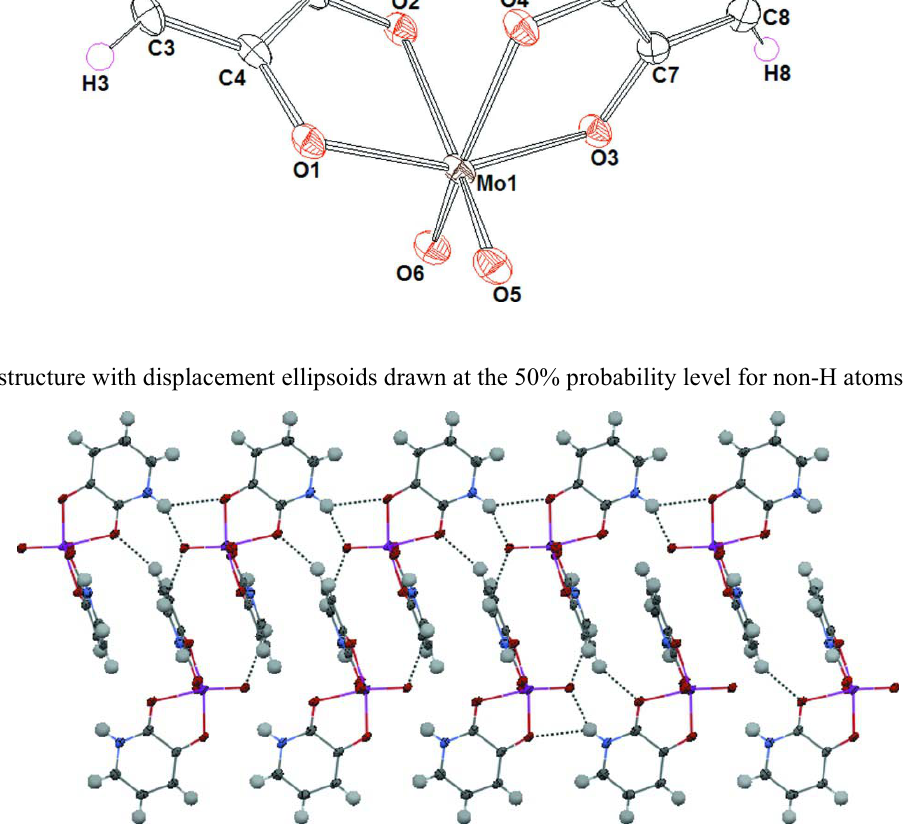
Figure 2 Parallel chains made through intermolecular N—H···O and C—H···O hydrogen-bond interactions (dashed